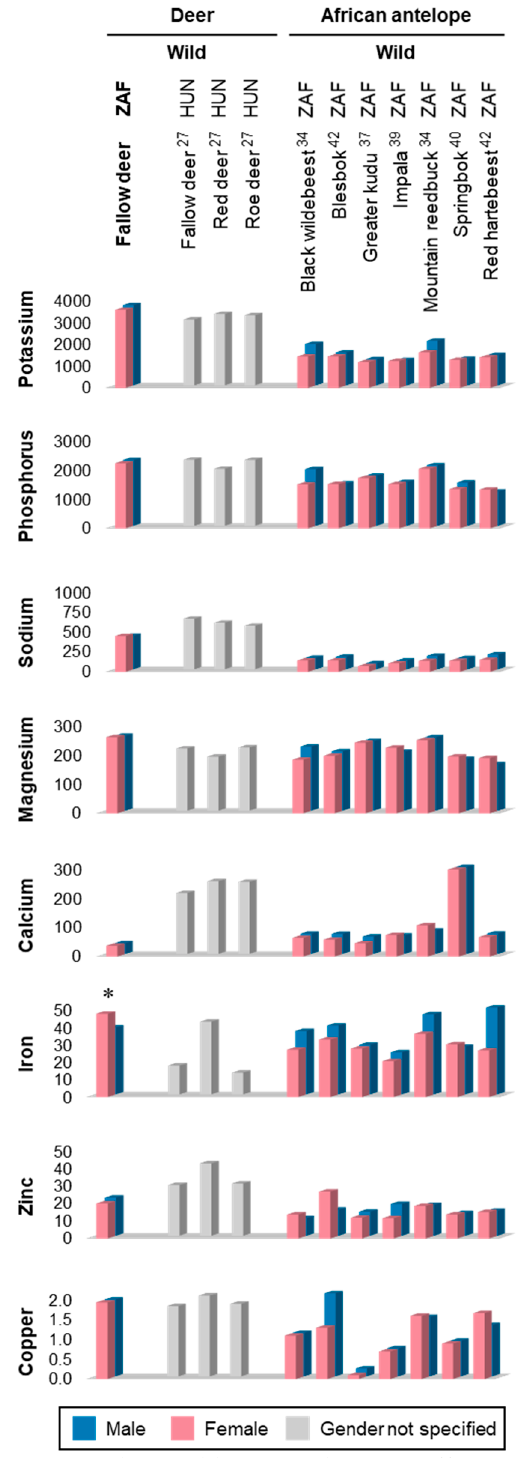
Figure 2. Mineral composition (mg / kg) of longissimus thoracis et lumborum muscles from selected game species, including sex comparisons where applicable. Values obtained in the present study appear in the first column (label marked in bold). The superscript numbers indicated after each species refer to references in the reference list [27,34,37,39,40,42]. * Indicates studies in which a significant sex e ff ect was found. Abbreviations: HUN = Hungary; ZAF = South